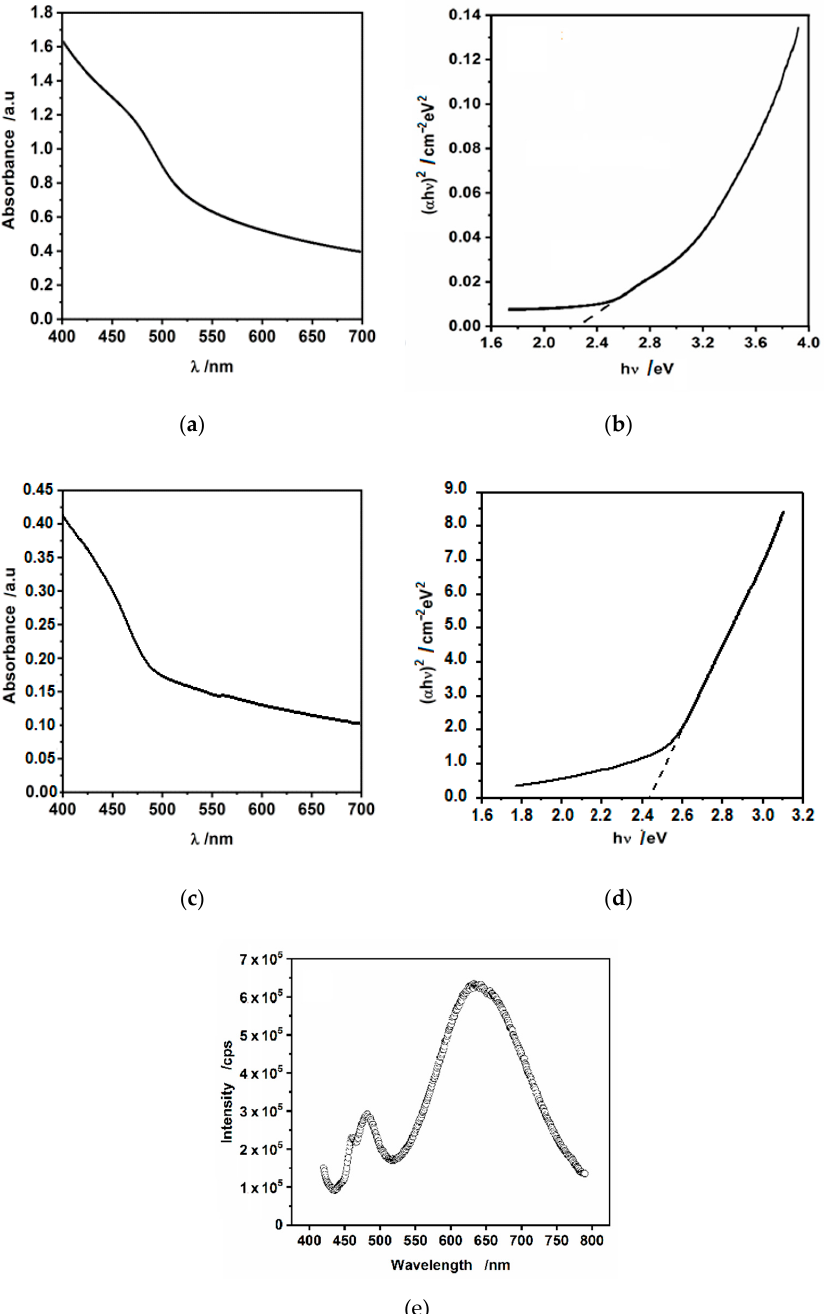
Figure 7. ( a ) UV-vis spectrum and ( b ) ( α h ν ) 2 vs. h ν dependence obtained forhydrophiic drop-cast CdS nanoparticles suspended in pristine water; ( c ) UV-vis spectrum and ( d ) ( α h ν ) 2 vs. h ν dependence obtained for the suspension of hydrophobic CdS nanoparticles in hexane; ( e ) PL spectrum of the suspension of hydrophobic CdS nanoparticles in hexane. UV-vis absorption spectrum of hydrophilic CdS nanoparticles is shown in Figure 7a. The corresponding Tauc plots (Figure 7b) yielded the energy bandgap of ca. 2.3 eV, being in good